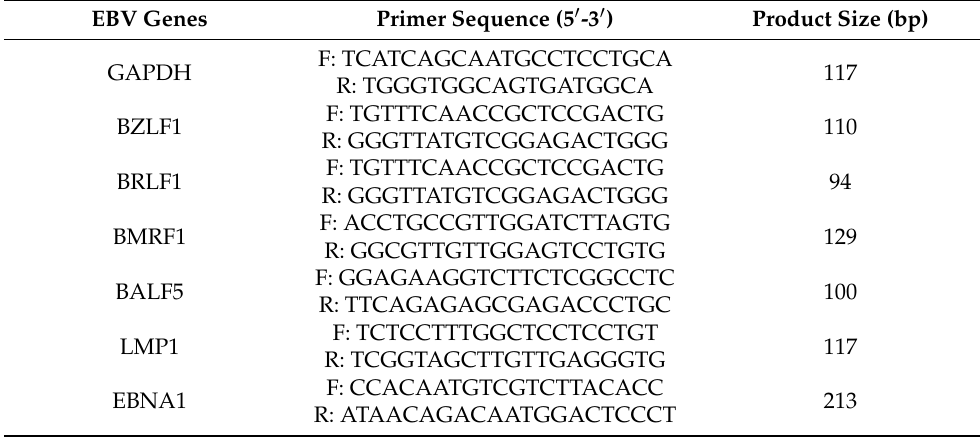
Table 2. EBV primer pairs